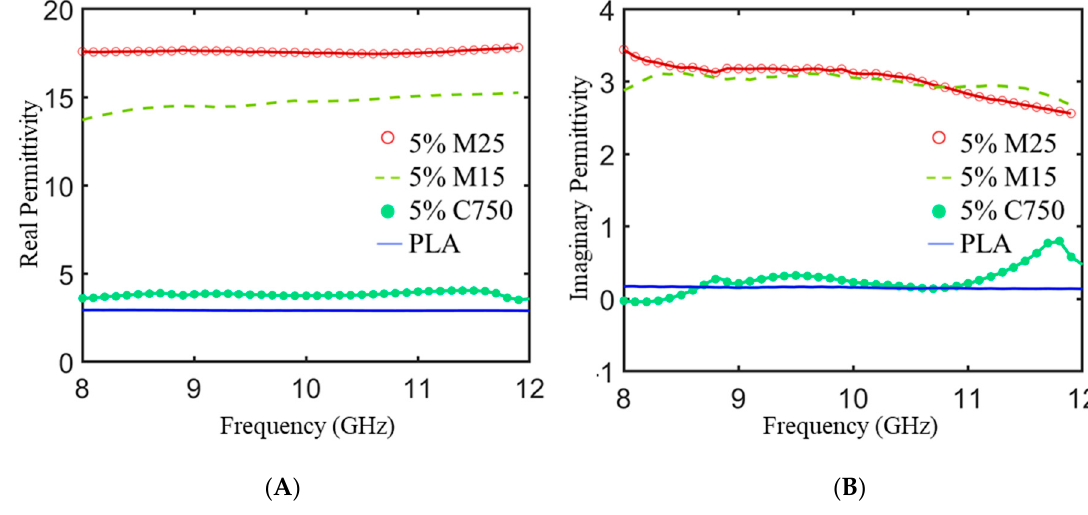
Figure 4. The real part ( A ) and imaginary part ( B ) of the complex permittivity for 5 wt % xGNP/PLA composites fabricated with different aspect ratio filler material. The properties of neat PLA are also displayed as reference.